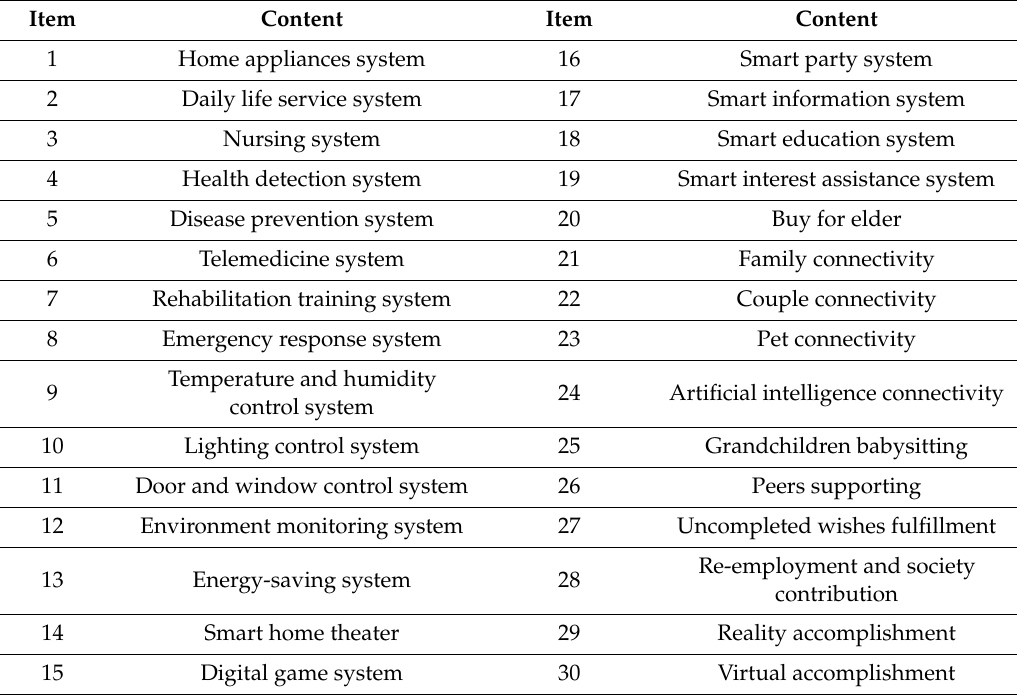
Table 2. Smart home subsystem items for new elders.